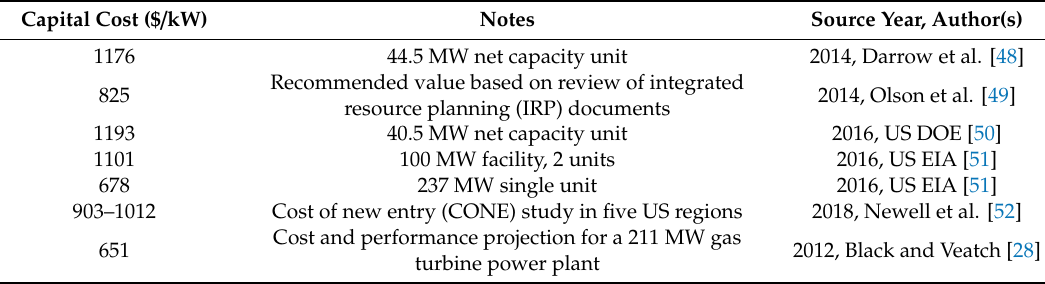
Table 9. Capital cost estimates—CT